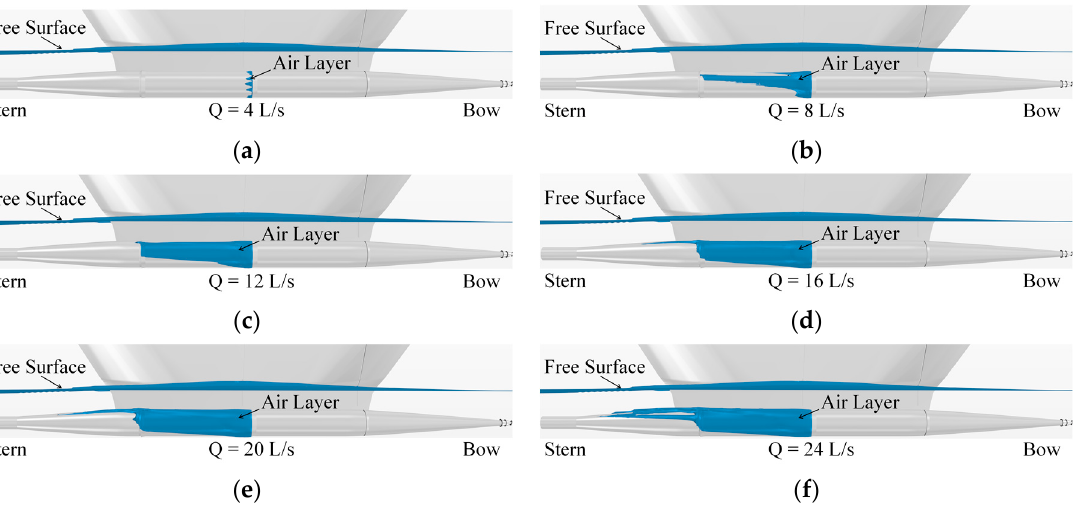
Figure 9. Air layer distribution with air injected from location L3: ( a ) Air fl ow rate Q = 4 L/s; ( b ) Air fl ow rate Q = 8 L/s; ( c ) Air fl ow rate Q = 12 L/s; ( d ) Air fl ow rate Q = 16 L/s; ( e ) Air fl ow rate Q = 20 L/s; ( f ) Air fl ow rate Q = 24 L/s.